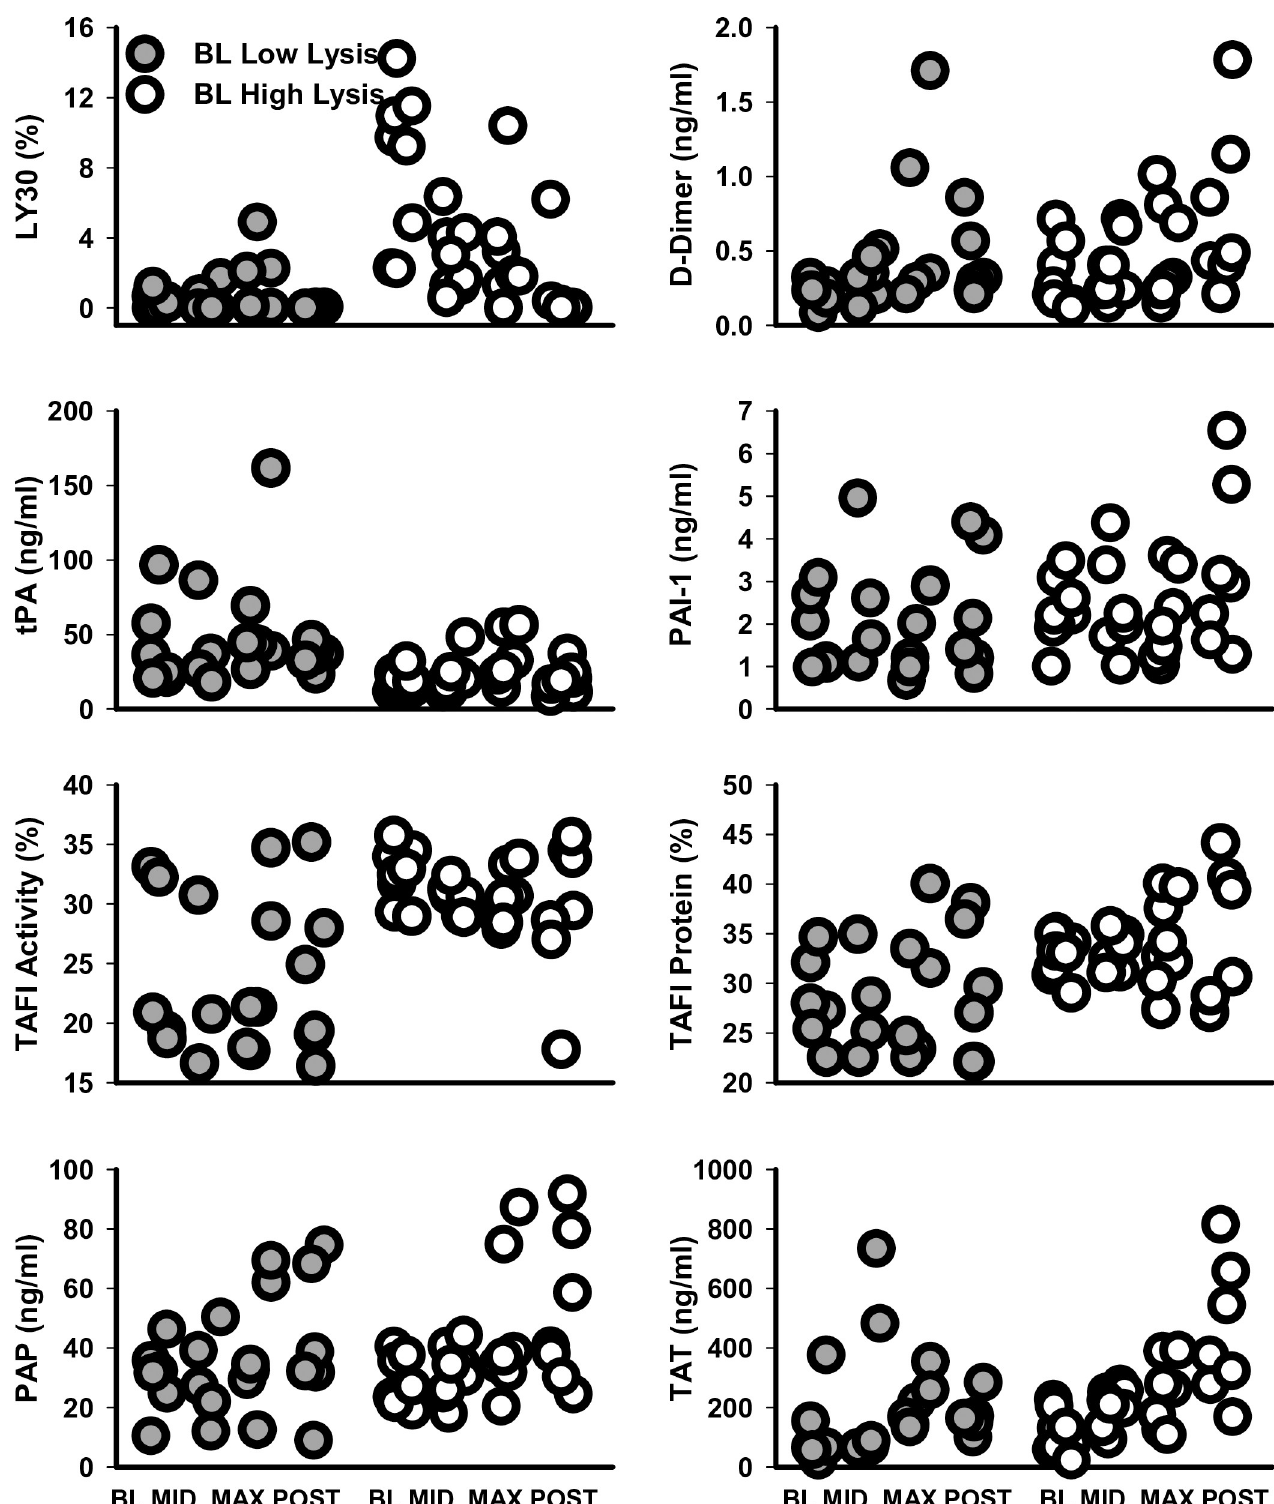
Fig 8. Post Hoc analysis of fibrinolytic indicators grouped low-lysis (LY30 BL < 2%) or high-lysis (LY30 BL > 2%) baboons whose fibrinolytic state matched at both HEM and LBNP BL. Swarm plots show all data points for fibrinolytic indicators LY30, D-dimer, tPA, PAI-1, TAFI-activity, TAFI-protein and PAP as well as the indicator of coagulation, TAT during HEM and LBNP treatment. Solid circles are BL low lysis; open circles are BL high lysis.